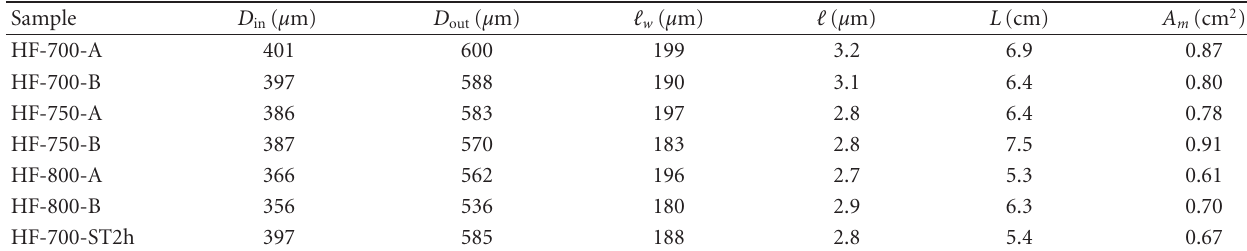
Table 2: Characteristics of the carbon membranes.